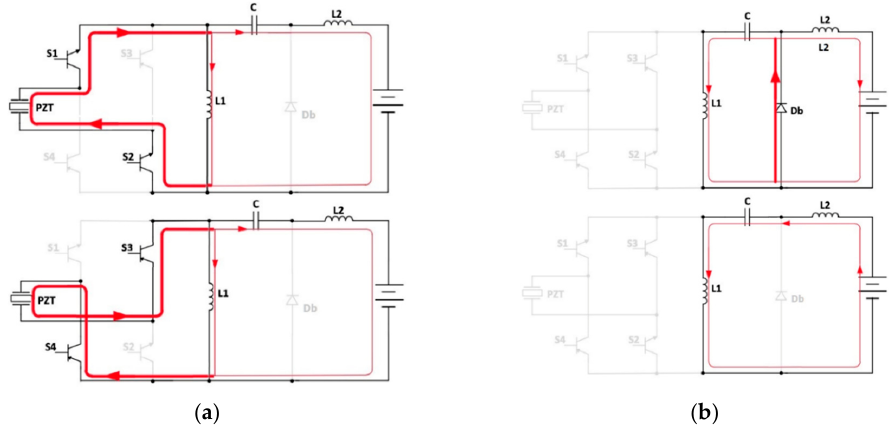
Figure 6. ( a ) Powering mode with v AC ( t ) > 0 (up) and v AC ( t ) < 0 (down); ( b ) free-wheeling mode (up), idle mode (down).